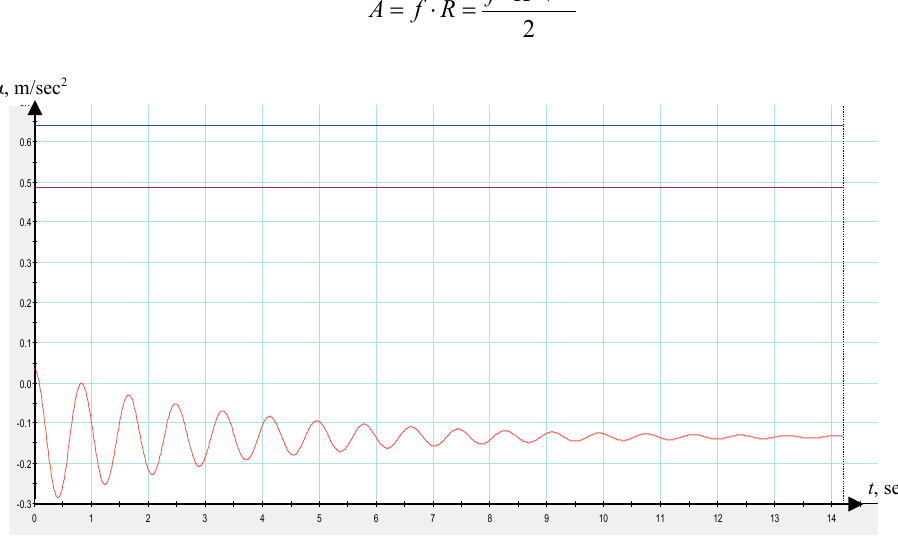
Fig. 8. Acceleration of the sprung weight by computer simulation method without a pendulum; weight per wheel m = 820 kg; the spring stiffness C = 2·10 4 N/m; the spring damping K = 2·10 2 Nm /sec 2 .